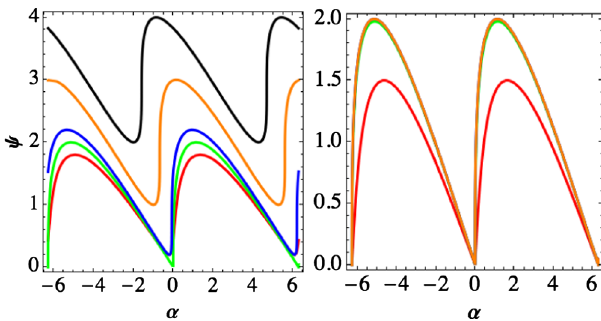
FIG. 2. (left) Retarded angle c as a function of (cid:4) when (cid:1) ¼ 1 , for x ¼ (cid:1) 0 : 2 ; 0 ; 0 : 2 ; 1 ; 2 (red, green, blue, orange, black curves, respectively). (right) Retarded angle c as a function of (cid:4) when x ¼ 0 , for (cid:2) ¼ 2 ; 10 ; 100 ; 1000 (red, green, blue, orange curves, respectively; orange curve is on top of the blue one).